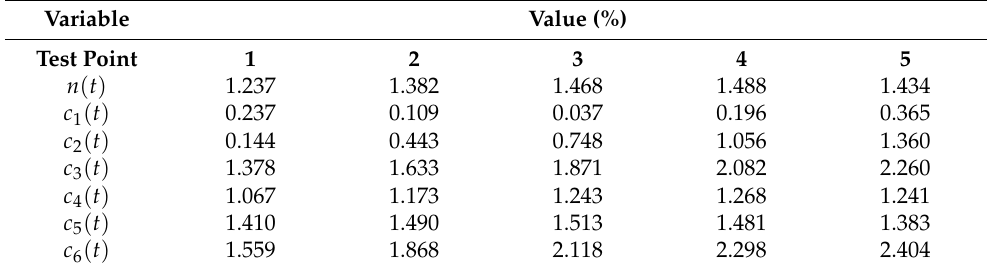
Table 4. Case 1. Percentage error of extrapolation of the training data in time interval t ∈ [ 0, 211 ] s using five testing points in time interval t ∈ [ 212, 217 ] s .